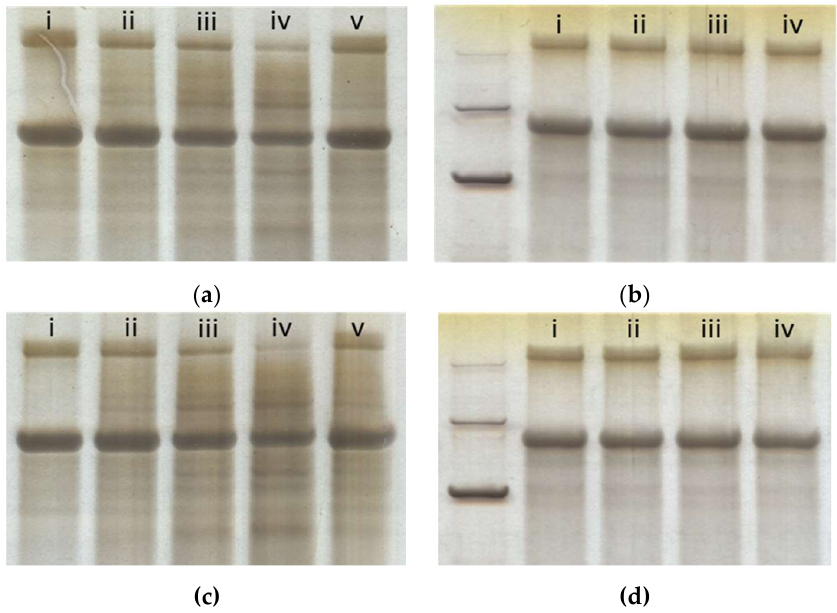
Figure 5. SDS-PAGE gels of ultrasonically atomised RHCIII, ( a,c ), and non-atomised RHCIII that was exposed to 1.65 MHz ultrasound, ( b,d ). Samples in gels ( c,d ) were digested with pepsin, whereas gels ( a,b ) are their non-digested controls. All lanes marked (i)–(iv) correspond to 0, 20, 60, and 120 min. Lanes marked (v) were re-solubilised printed samples. Molecular weight standards in the left-most lane of ( b ) and ( d ) mark 250, 150, and a high-intensity band at 100 kDa.